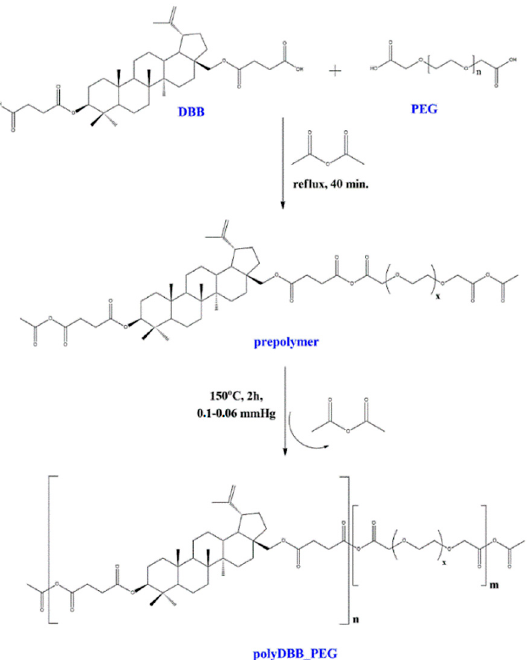
Figure 1. Reaction scheme of the synthesis of polyanhydrides based on disuccinate betulin (DBB) and dicarboxylic derivatives of PEG.